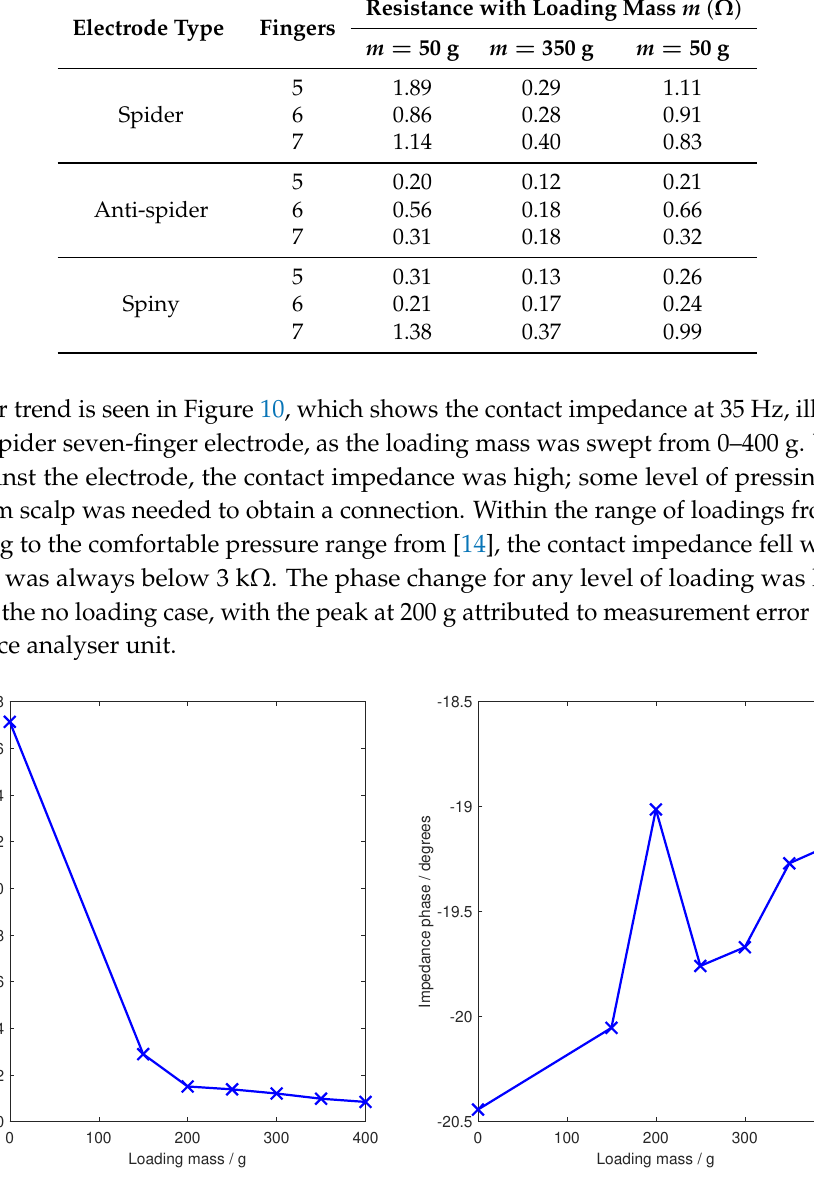
Figure 10. Contact impedance for the spider seven-finger electrode, measured at 35 Hz to match on-person contact impedance readings as the contact loading is varied across the comfortable